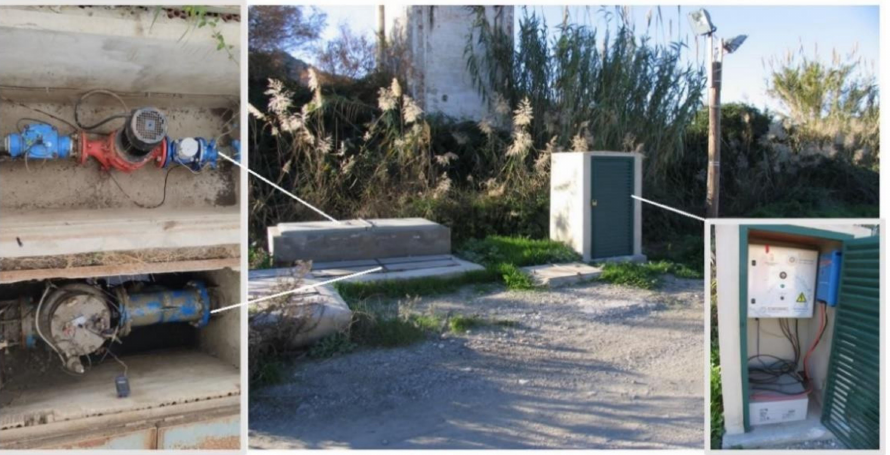
Figure 5. Experimental system site. The three main compartments are detailed. Reducing valve ( bottom left ); ERT ( top left ) and energy storage and control panel ( right ).